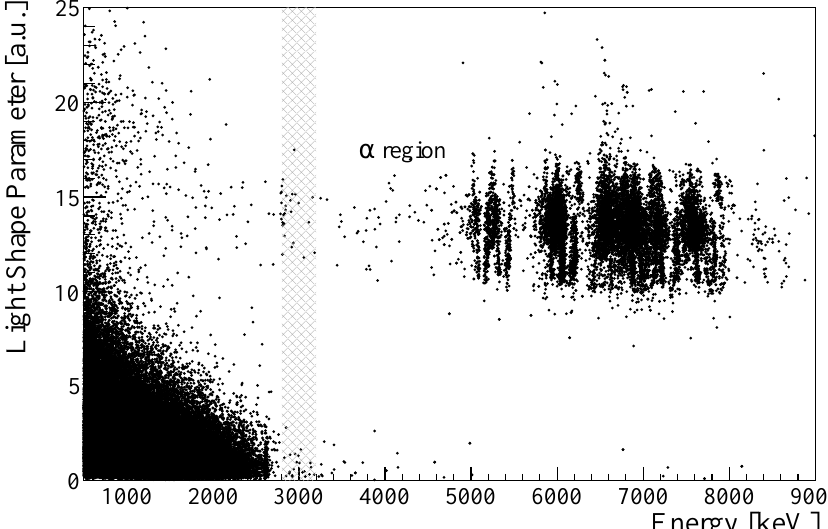
Figure 1. Light shape parameter as a function of the energy released in the ZnSe (all crystals). The dashed vertical band region identifies the 400 keV region centered around the 82 Se Q ββ used for the 0 νββ analysis and for the background evaluation. The α events are concentrated in the right upper region while β / γ events populate the left lower corner. The Figure is adapted from Ref.